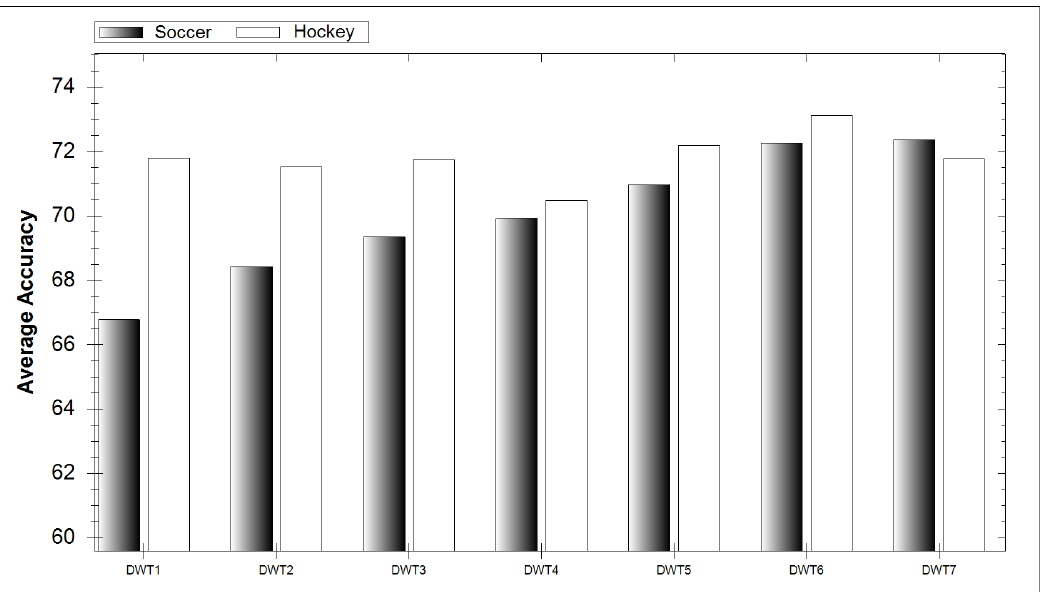
Figure 5. Effect of DWT Levels on classification accuracy.